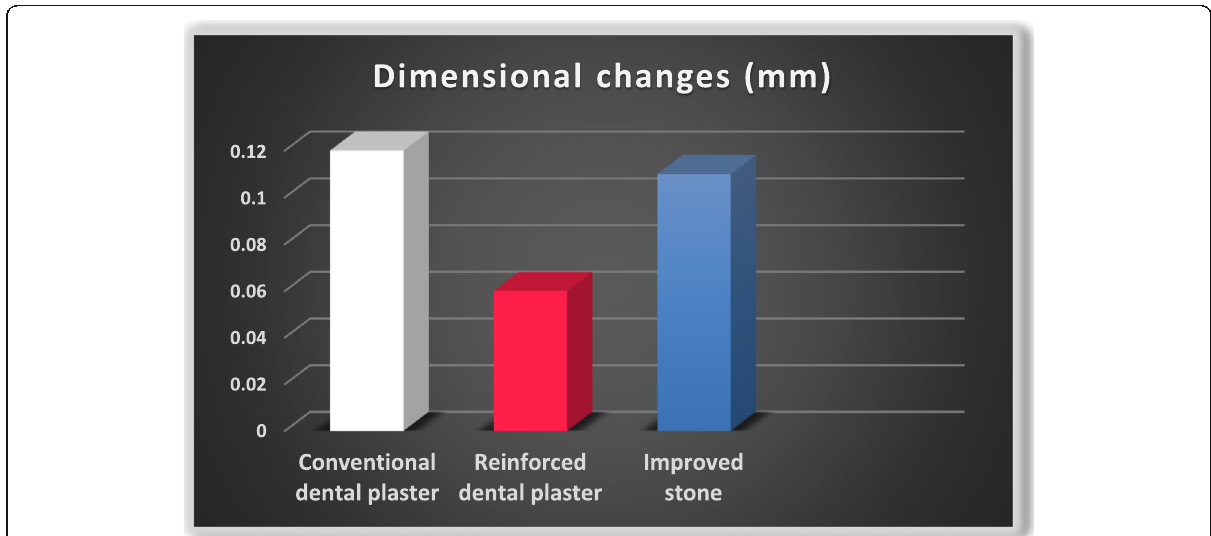
Fig. 6 Histogram showing mean dimensional changes % between the three